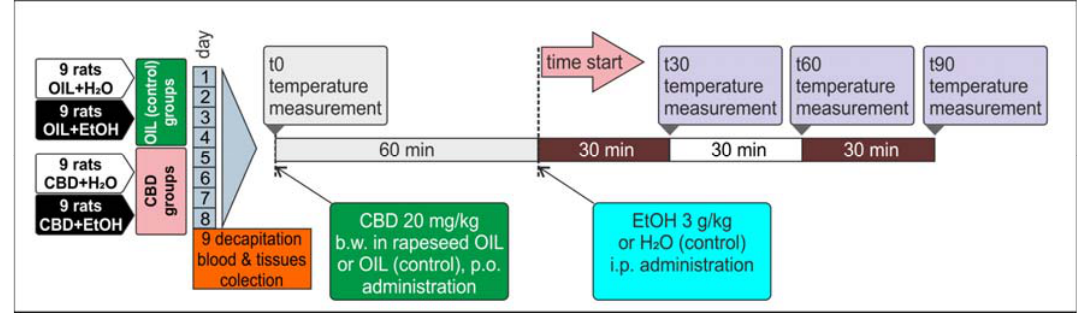
Figure 1. Alcohol tolerance development during a nine ‐ day CBD and EtOH administration.